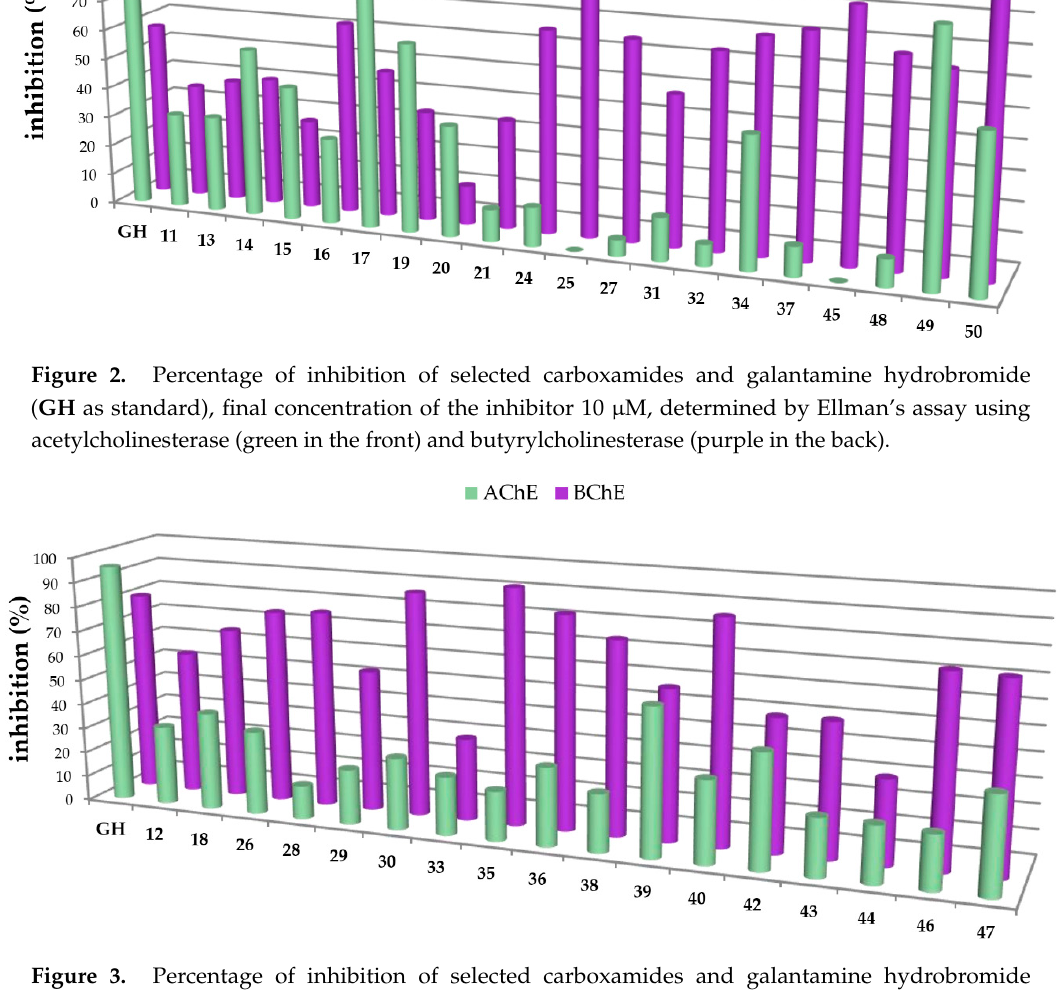
Figure 3. Percentage of inhibition of selected carboxamides and galantamine hydrobromide ( GH as standard), final concentration of the inhibitor 30 µM, determined by Ellman’s assay using acetylcholinesterase (green in the front) and butyrylcholinesterase (purple in the back).